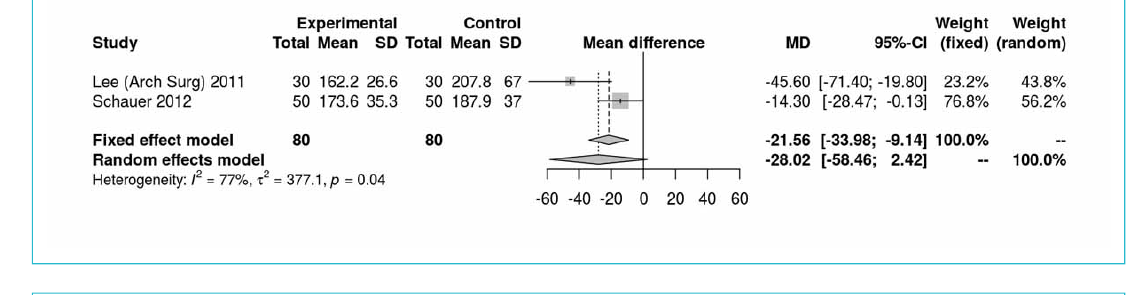
Figure S6p: Triglycerides at baseline (analysis of studies including only patients with type 2